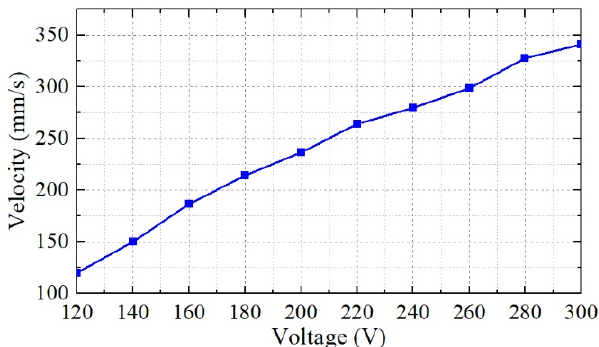
Figure 9. The output velocity versus the input excitation voltage amplitude.